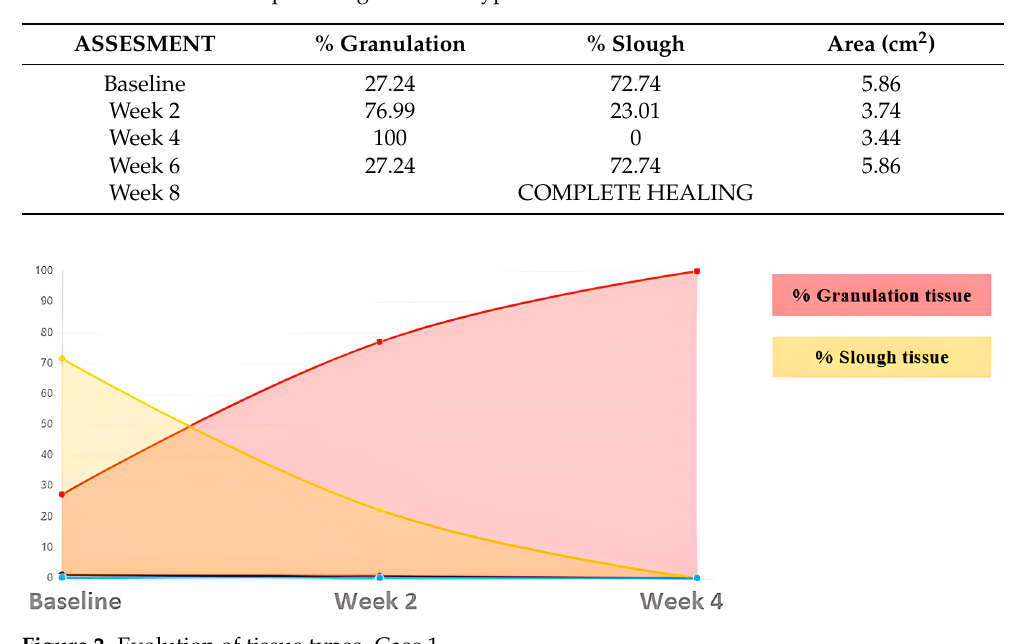
Figure 1. Healing evolution case 1: Baseline assessment ( left ), Baseline HELCOS analysis ( centre ), Week 6 assessment ( right ). Table 2. Evolution in the percentage of tissue types and areas Case 1.